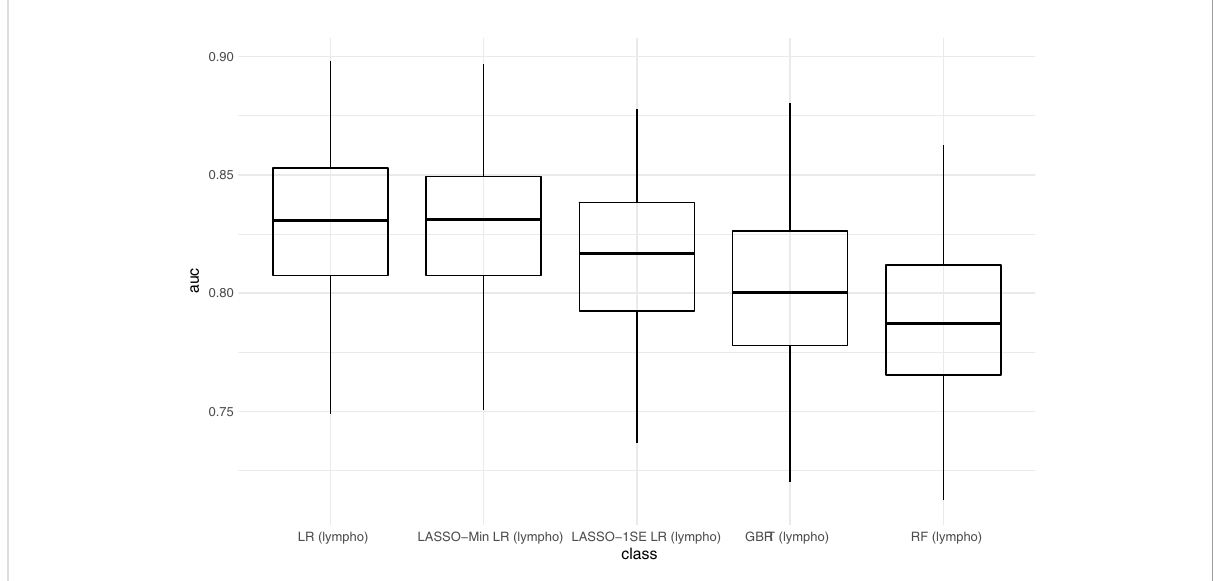
FIGURE 3 Predictive performance of the developed models (AUC) in internal validation. Each point represents the AUC-ROC during 1 out of 100 resampling steps. Horizontal lines within the box depict the median and the upper and lower horizontal lines depict upper and lower quartiles, respectively. LR - logistic regression, LASSO-Min LR - least absolute shrinkage and selection operator regularized logistic regression with lambda hyperparameter optimized to yield maximum AUC-ROC within an inner 5-fold cross validation in the training set. LASSO-1SE - least absolute shrinkage and selection operator regularized logistic regression with lambda hyperparameter increased from lambda-min, so that AUC-ROC stays within one standard error within an inner 5-fold cross validation in the training set. GBRT - gradient boosted regression trees. RF - random forest. lympho – including lymphocyte count as predictor variable.